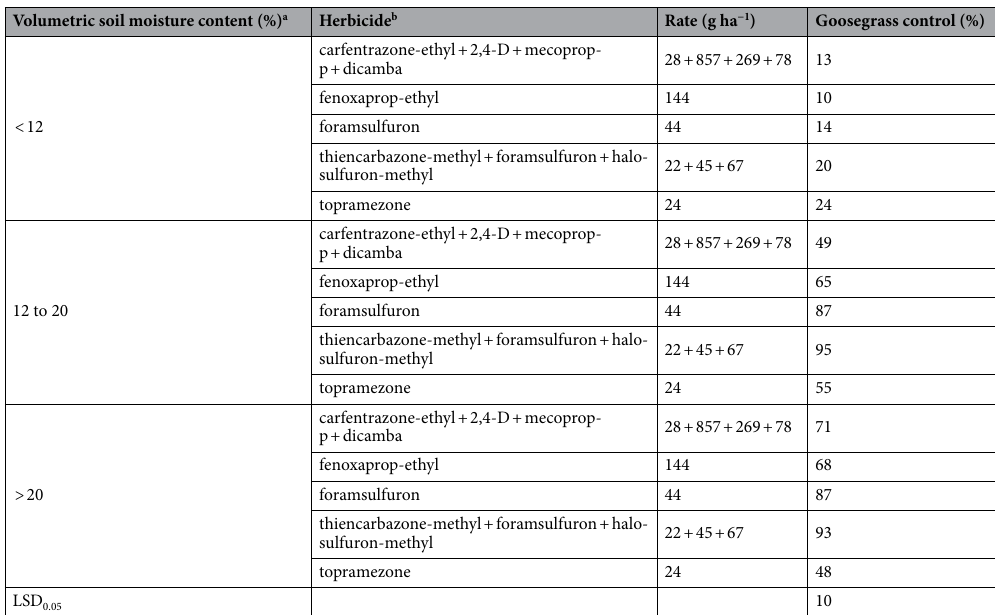
Table 1. Effect of a soil moisture-by-herbicide-interaction on goosegrass [ Eleusine indica (L) Gaertn] control with postemergence herbicides 36 days after treatment in a glasshouse experiment conducted the University of Tennessee (Knoxville, TN) in November 2018. a Volumetric soil moisture content measured daily